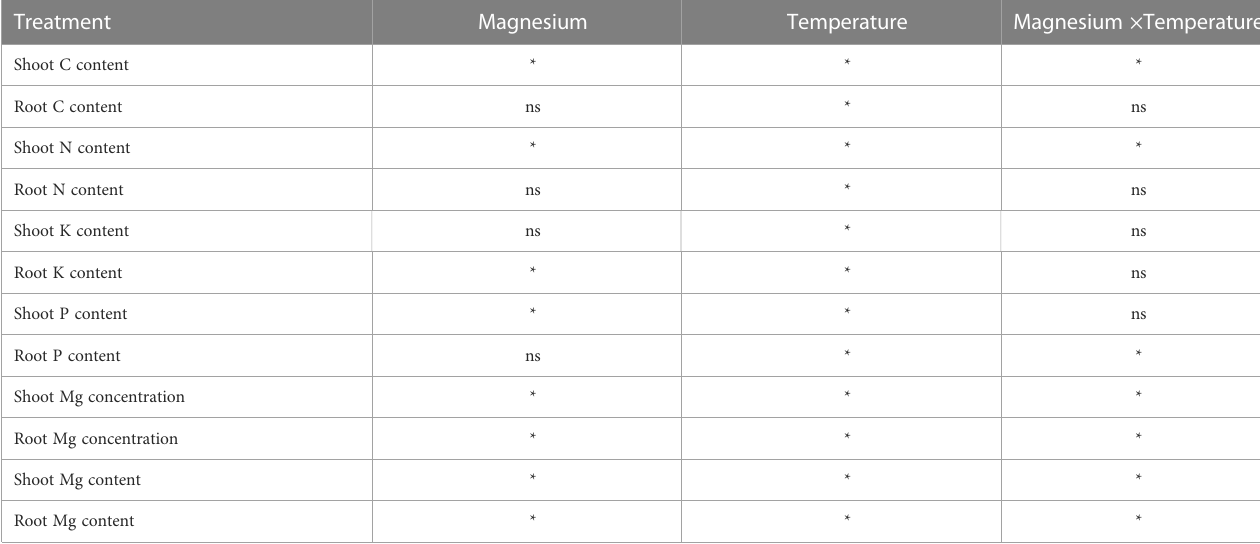
TABLE 2 Results of Two-way ANOVAs on tobacco nutrients uptake. Treatment